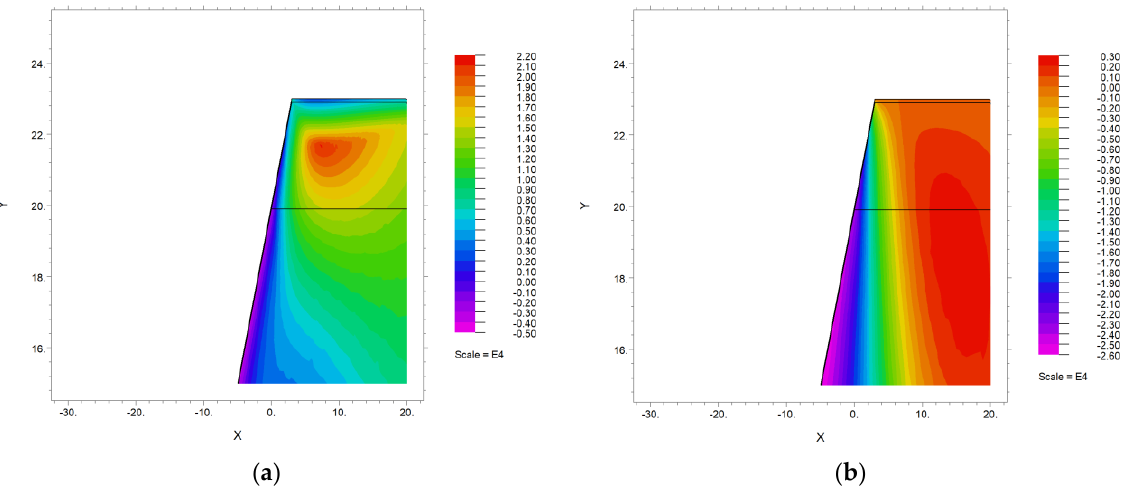
Figure 14. Calculation results for the slope inclination of 1:1 — ( a ) Coulomb – Mohr potential, ( b ) shear stresses.